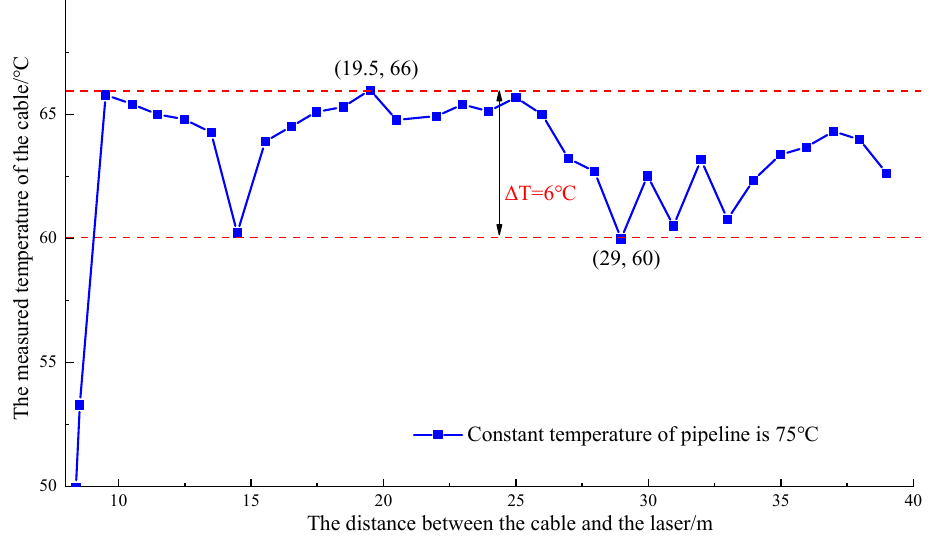
The distance between the cable and the laser/m Figure 10. Image of pipeline constant temperature operation test. Figure 10. Image of pipeline constant temperature operation test. Figure 10. Image of pipeline constant temperature operation test.